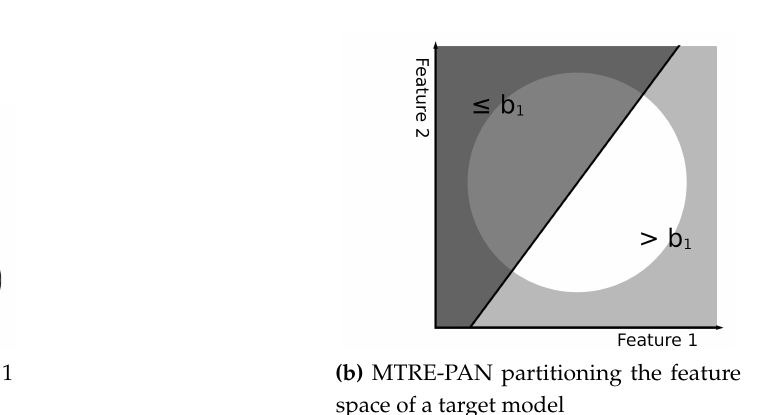
Figure 1. ( a ) represents a trained MTRE − PAN model of depth 1, with the hyperplane(s) acting as separators. It shows how an input vector X i is classified to the correct leaf using the constraints C 1 and the bias b 1 as per Equations (1) and (2). ( b ) illustrates how MTRE − PAN partitions the feature space of an existing target model. For this example, the decision boundary is a circle. The light regions are assigned label 1, and the dark regions are assigned label − 1.